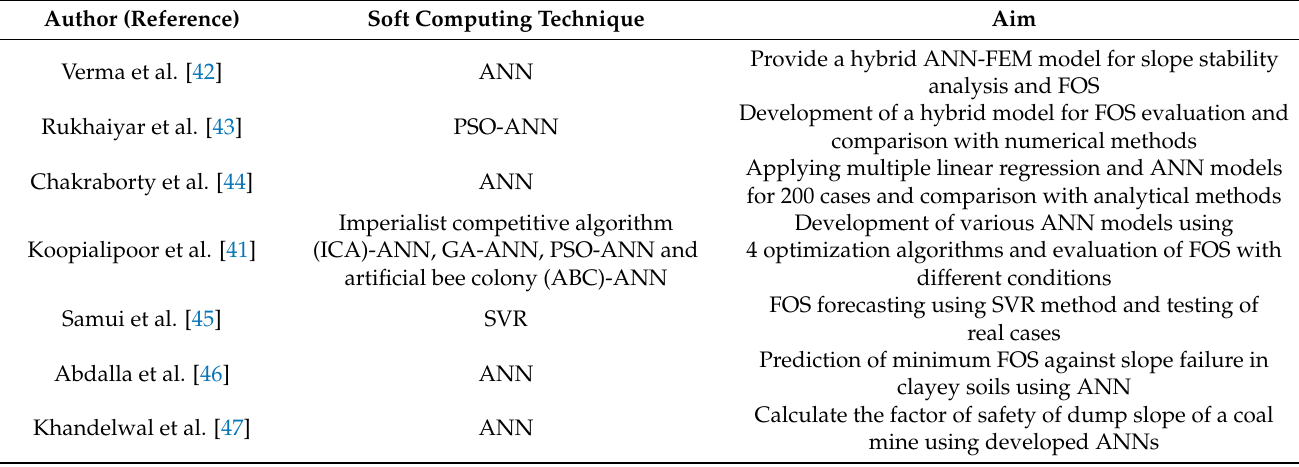
Table 1. Summary of some studies that applied soft computing techniques to evaluate the factor of safety (FOS). Soft Computing Technique Aim Provide a hybrid ANN-FEM model for slope stability ANN analysis and FOS Development of a hybrid model for FOS evaluation and PSO-ANN comparison with numerical methods Applying multiple linear regression and ANN models for 200 cases and comparison with analytical methods Development of various ANN models using 4 optimization algorithms and evaluation of FOS with different conditions FOS forecasting using SVR method and testing of real cases Prediction of minimum FOS against slope failure in clayey soils using ANN Calculate the factor of safety of dump slope of a ANN